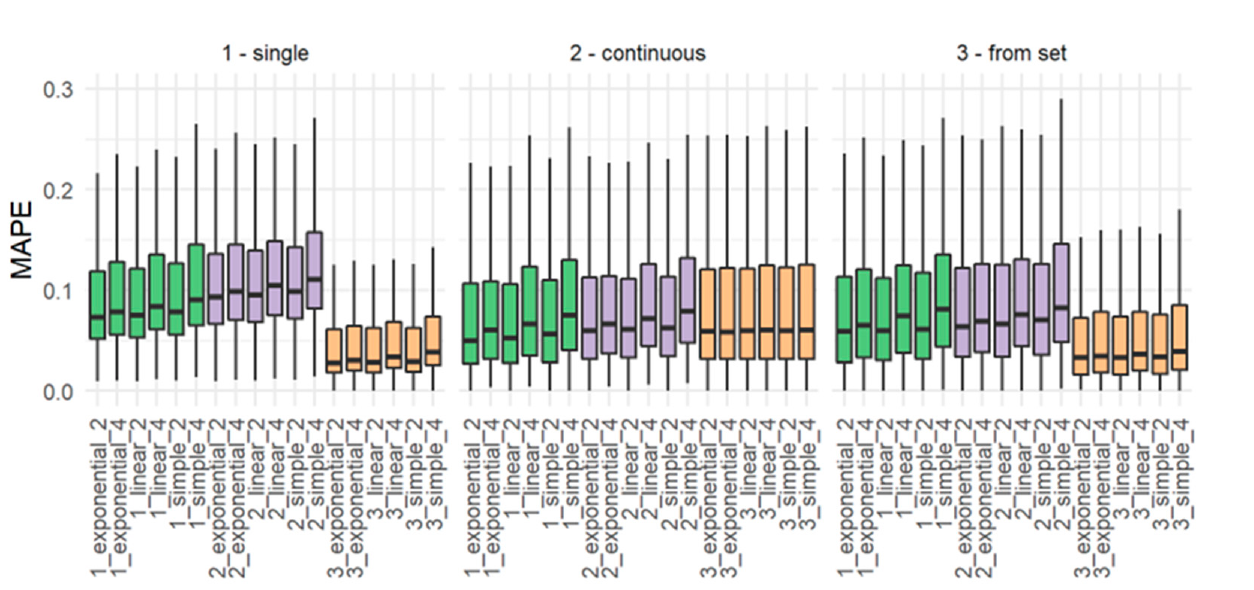
Figure 6. Quartiles of MAPE values for individual imputation methods. Source: own elaboration.